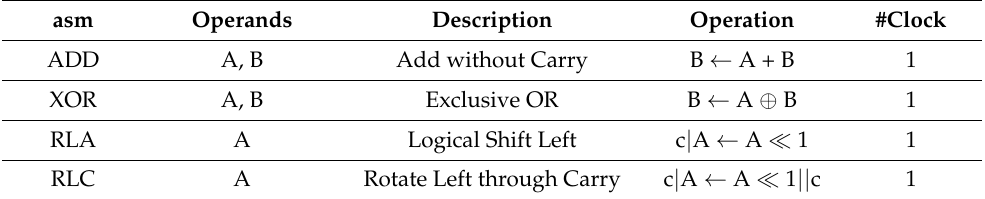
Table 1. Instruction set summary of ARX operations on the 16-bit MSP430 microcontroller, where c represents carry bit.